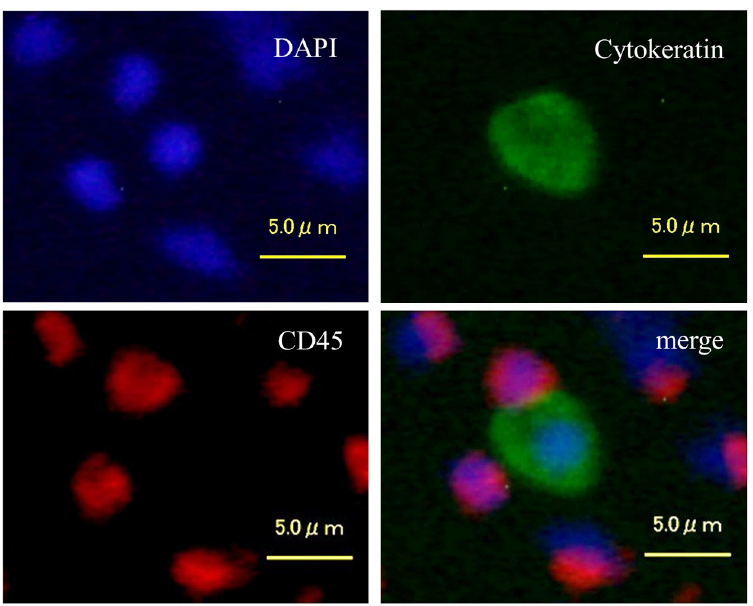
Fig 1. Fluorescence microscopy images of cells isolated from peripheral blood of HCC patients by positive immunomagnetic separation. Images of cells stained with DAPI (blue), anti-cytokeratin antibodies (green), and CD45 antibodies (red) and the corresponding merged image are shown. Cytokeratin-positive cells are CTCs, whereas CD45-positive cells are lymphocytes. https://doi.org/10.1371/journal.pone.0217586.g001 CTCs � 5 (odds ratio [OR]: 14.60; 95% CI: 3.27–106.14; p < 0.001) and AFP level � 60 ng/mL (OR: 9.35; 95% CI: 1.68–76.88; p = 0.010) as independent risk factors for mPVI (Table 3).